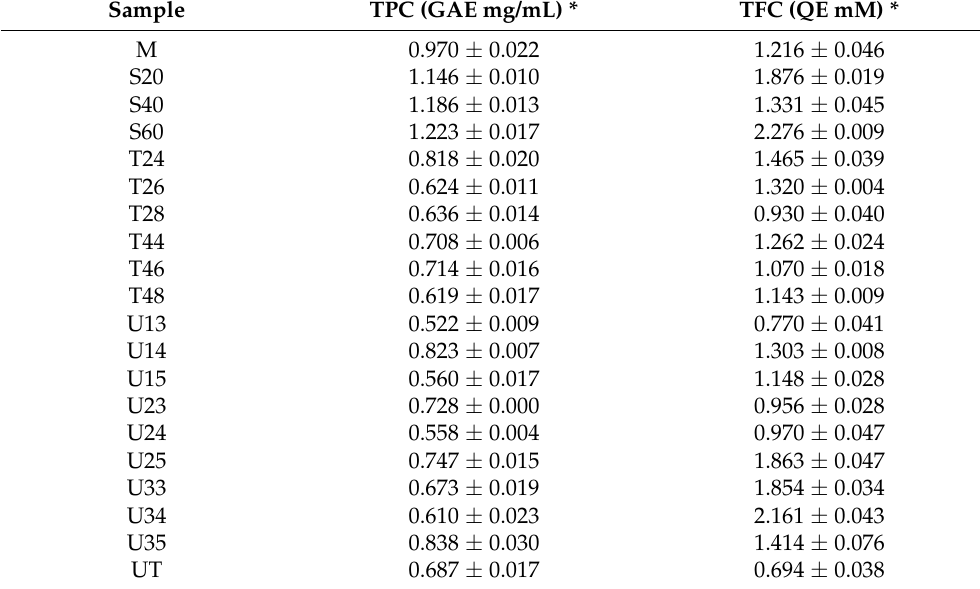
Table 2. TPC and TFC of the